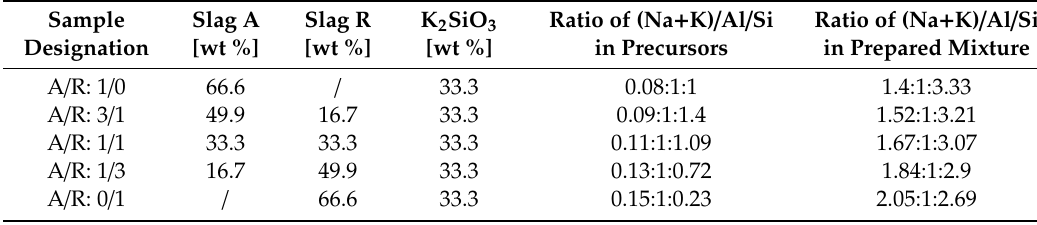
Table 2. Overview of the composition of di ff erent mixtures prepared for the investigation with the calculated (Na + K) / Al / Si ratios in the precursor material as well as prepared